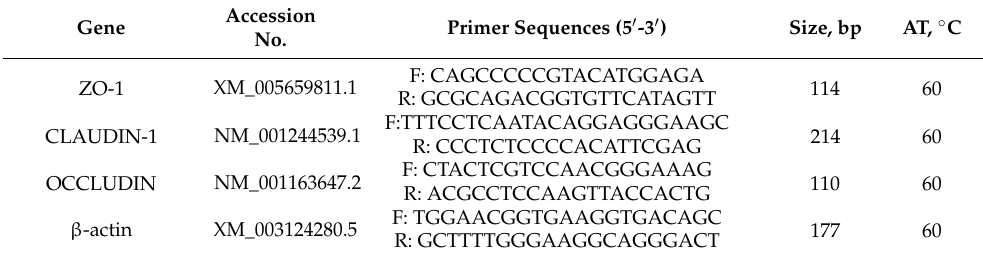
Table 2. Primer sequences used for real-time